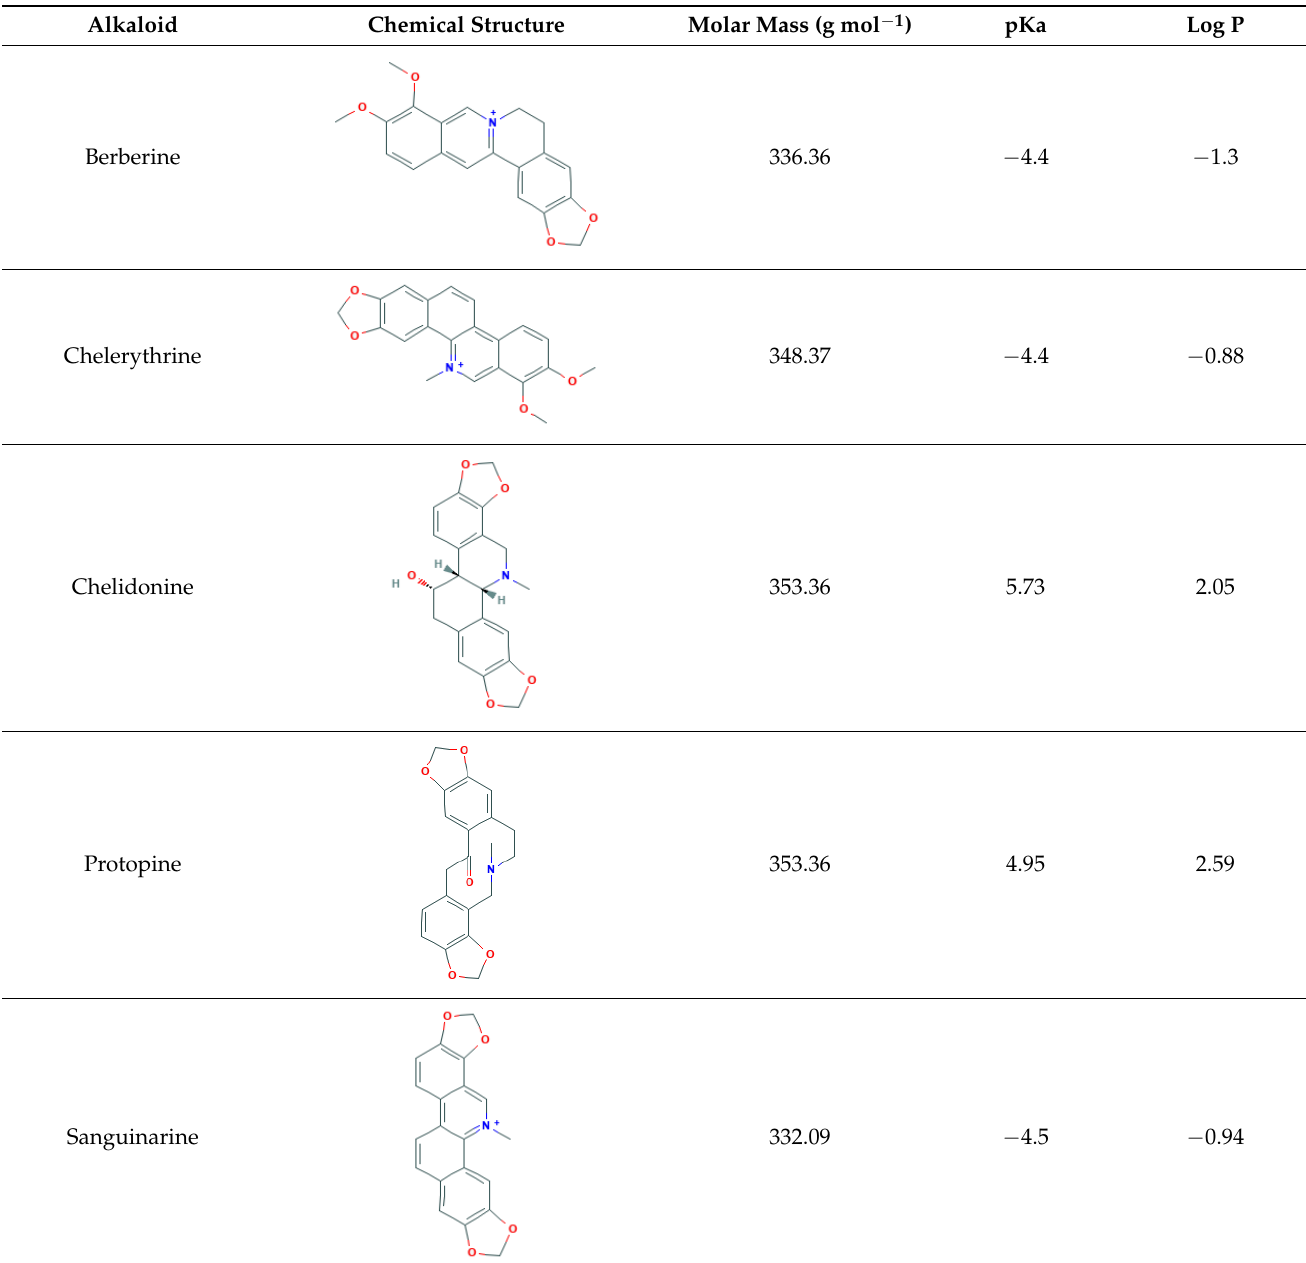
Table 1. Physicochemical properties of the selected alkaloids.